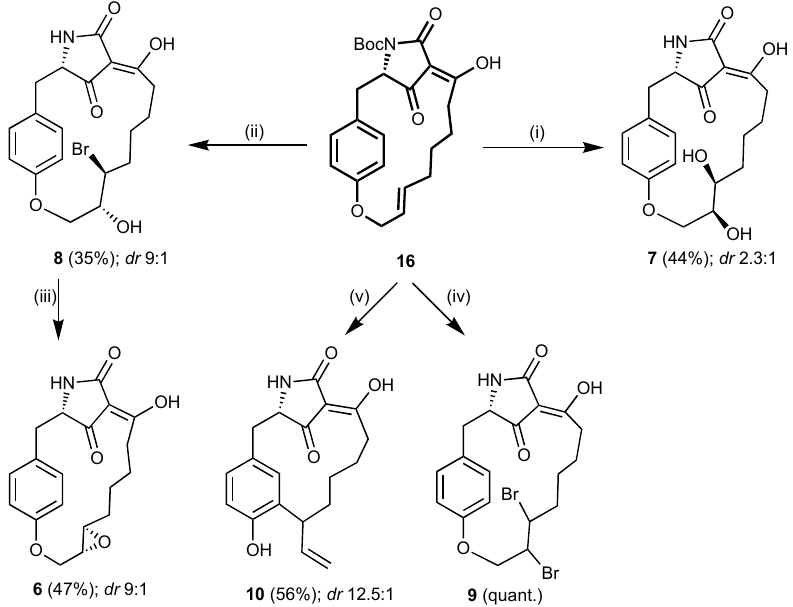
Scheme 2. Modular synthesis of macrocidin derivatives 6 – 10 starting from key intermediate 16 .